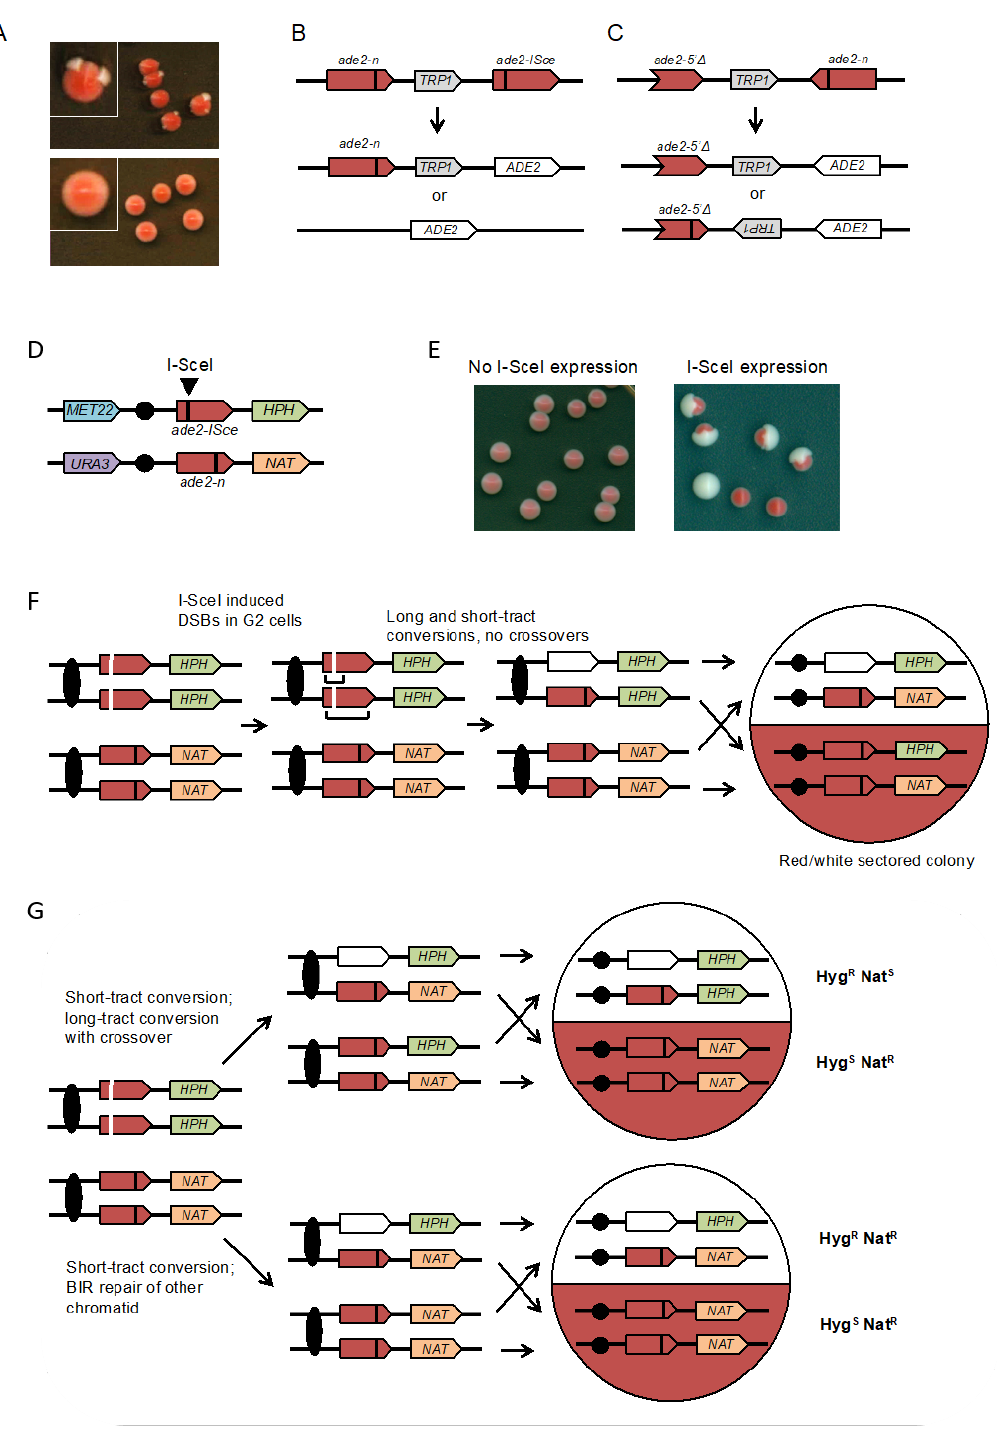
FIGURE 3: Colony color sectoring assays to detect spontaneous or DSB-induced recombination in haploid and diploids cells. (A) The upper panel shows wild-type colonies with the inverted-repeat reporter; rad52Δ (recombination-deficient) colonies are shown in the lower panel. (B) Direct-repeat recombina- tion reporter: the ade2-n allele was generated by restriction enzyme fill-in of a Nde I site, the ade2-ISce allele was made by inserting the I-SceI cut site at the Aat II site. Gene conversion events retain the TRP1 marker, whereas crossovers (CO) or SSA result in loss of TRP1 . (C) Inverted-repeat recombination reporter: the ade2-n and ade2- 5’Δ alleles are place in inverted orientation and separated by TRP1 . Gene conversion events retain TRP1 in the original configuration, whereas CO or long-tract sister-chromatid conversion flips the orientation of TRP1 . (D) Diploid with ade2-n and ade2-ISce heteroalleles, heterozygous mark- ers 150 kb downstream of the ade2 loci and heterozygous markers on the other chromosome arm. (E) Examples of colonies before and after I-SceI induction. (F) I-SceI cuts both chromatids with the ade2-ISce allele in G2 cells and repair occurs by short or long tract conversion yielding ADE2 or ade2-n allele, respec- tively. If both conversion events are non-CO, the colony is white/red sectored and the two halves retain heterozygosity for HPH (hygromycin resistance) and NAT (nourseothricin resistance). (G) If repair of one chromatid is associated with a CO and the recombinant chromatids segregate to different daughter cells, reciprocal LOH is detected. Note that if the recombinant chromatids segregate to the same daughter cell at mitosis, the CO is not detected and this must be taken into account when calculating the frequency of CO. BIR results in a half sector that retains heterozygosity and the other has LOH of the HPH